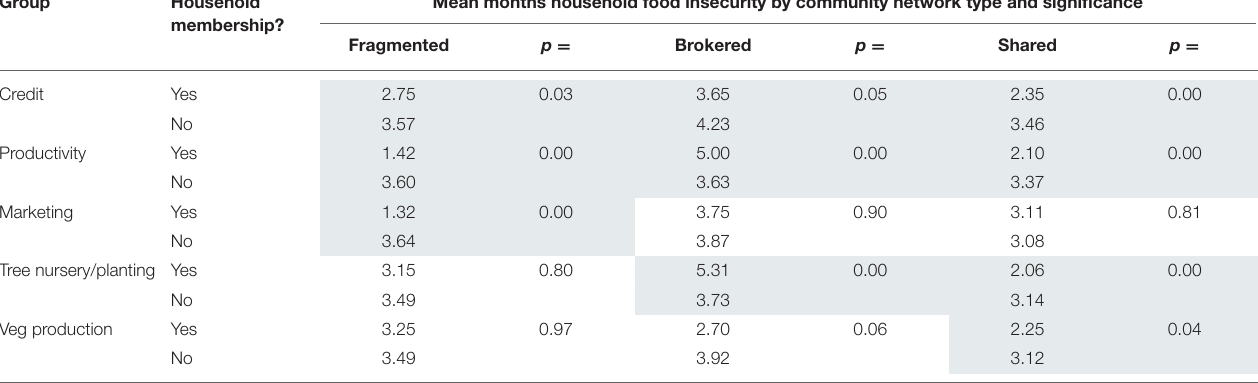
TABLE 2 | Mean months of food insecurity by network type and household group membership type. Group Household